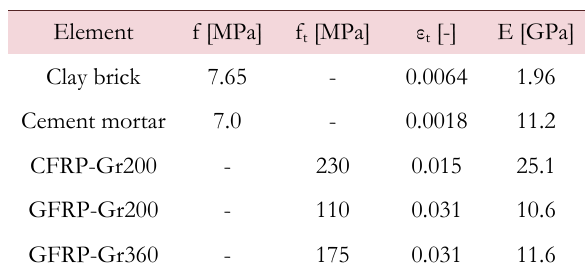
Table 5.A: Mechanical properties of constituents for the experimental tests [37].